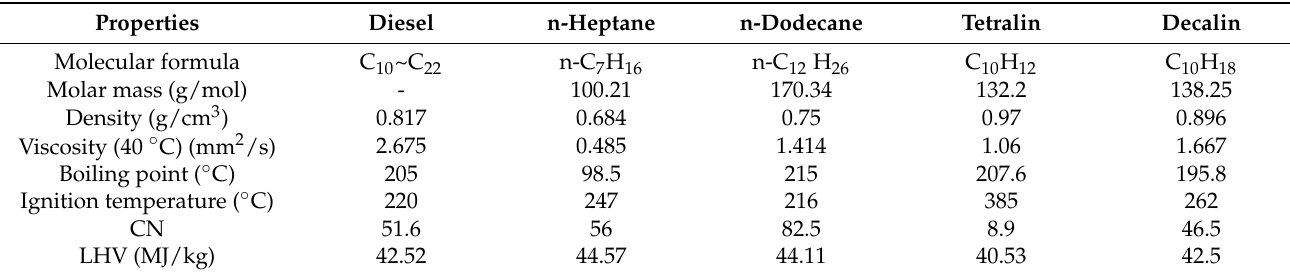
Figure 1. The molecular structure of n-heptane, n-dodecane, tetralin, and decalin molecules. Table 1. Properties of the test fuels.